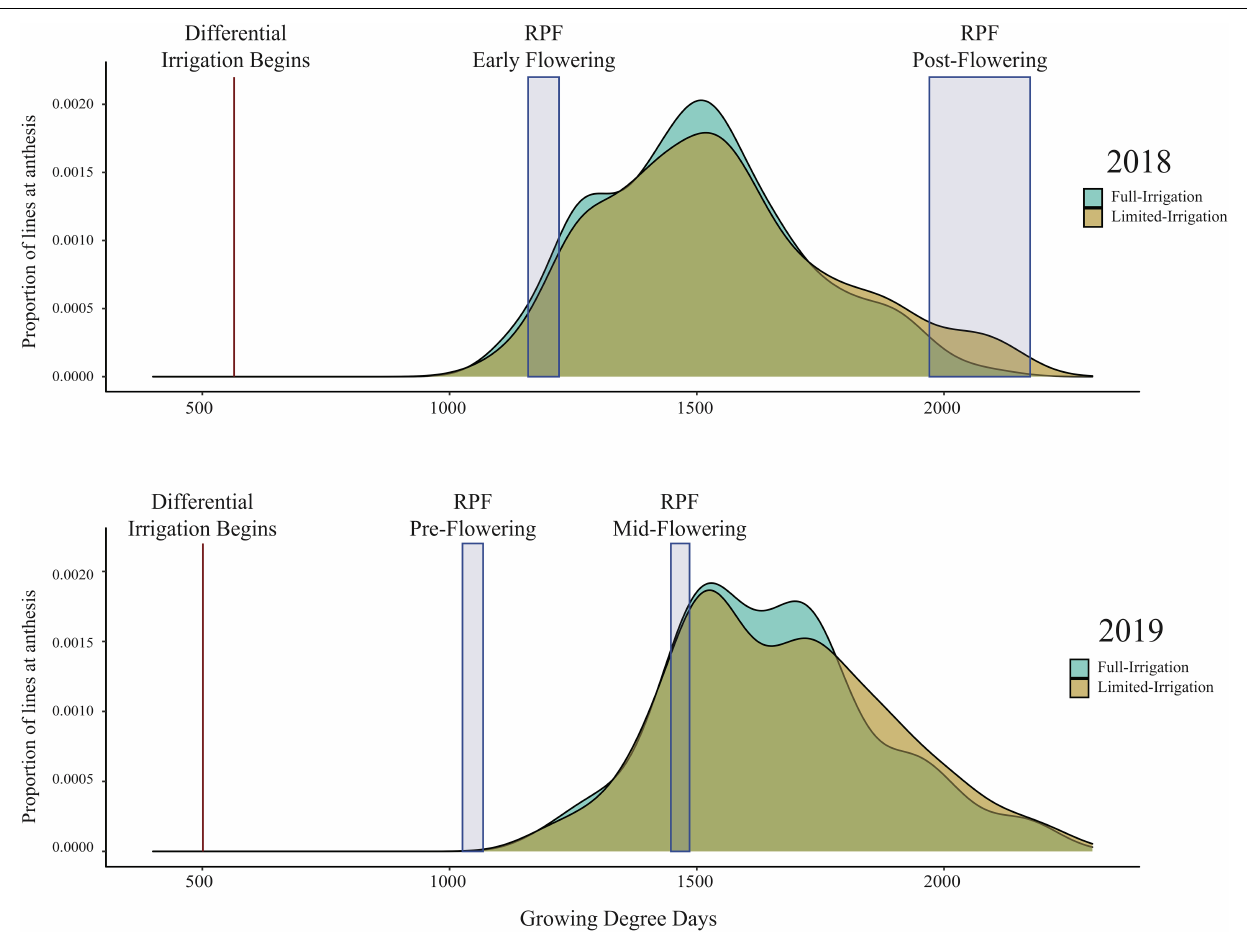
FIGURE 1 | Histogram of days to anthesis for the field experiments. The timing of the root pulling events are highlighted and assigned developmental stages relative to flowering: pre-flowering for the pulling at 71–73 days after planting, prior to any lines reaching anthesis, early flowering at 61–66 days after planting when roughly 5% of lines had reached anthesis, mid-flowering at 91–93 days from planting when roughly 30% had reached anthesis, and post-flowering at 109–119 days from planting when 98% of lines had reached